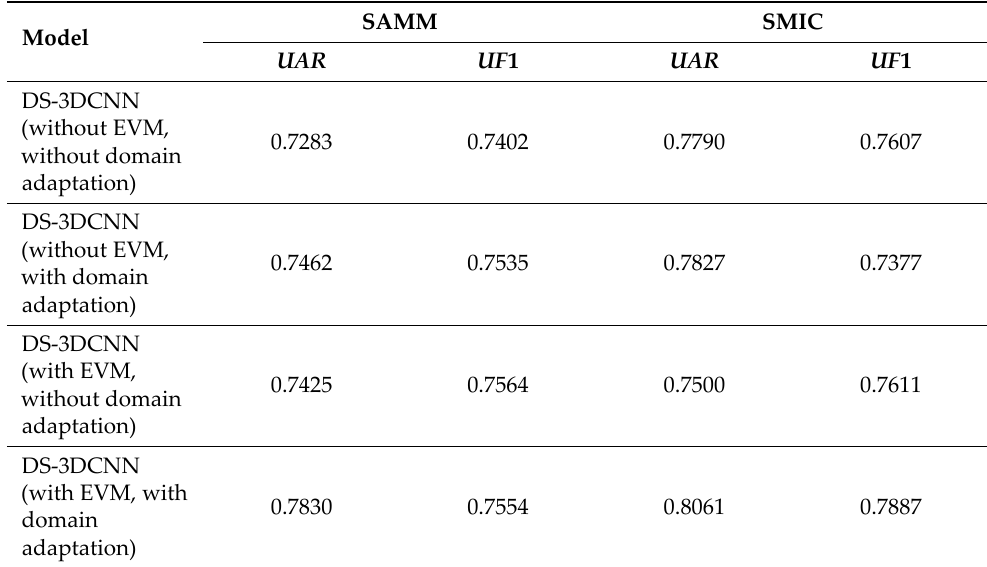
Table 7. Performance of DS-3DCNN with and without using EVM.